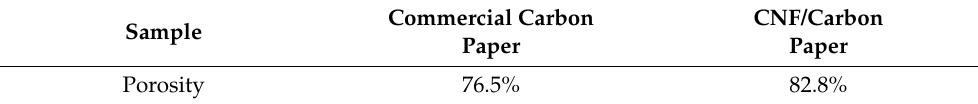
Table 1. The porosity of hydrophobic commercial carbon paper and CNF/carbon paper.